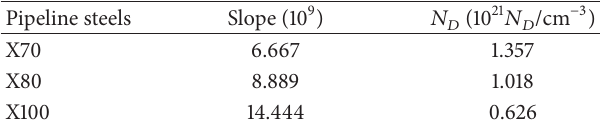
Table 2: The calculated donor density in the passive films for X70, X80, and X100 steels.